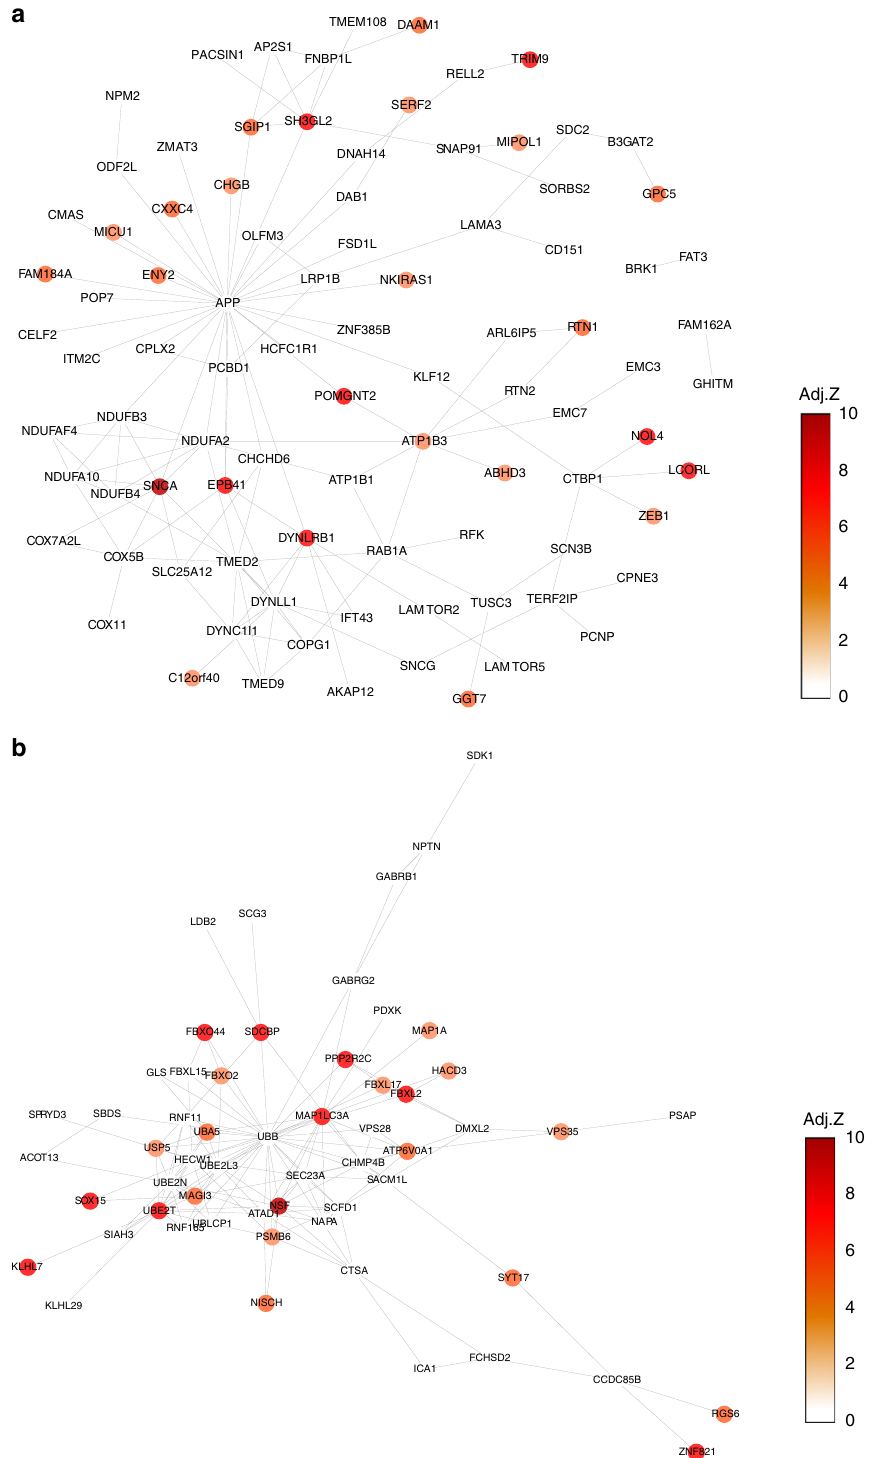
Fig. 5 Cell-type-speci fi c protein – protein interaction networks of Parkinson ’ s risk-associated genes. Protein – protein interaction (PPI) network representations of Parkinson ’ s risk-associated genes within substantia nigra (SN) dopaminergic neurons (DaN) speci fi c modules DaN_M1 ( a ) and DaN_M2 ( b ). We display all the genes found within each of two DaN-speci fi c PPI gene modules associated with Parkinson ’ s disease risk (Fig. 4) and colour each gene according to that gene ’ s Parkinson ’ s risk association MAGMA adjusted Z -score, with darker colours corresponding to higher adjusted Z -scores and a stronger Parkinson ’ s risk association. Edges between genes indicate an interaction between those genes ’ protein products (see “ Methods ”